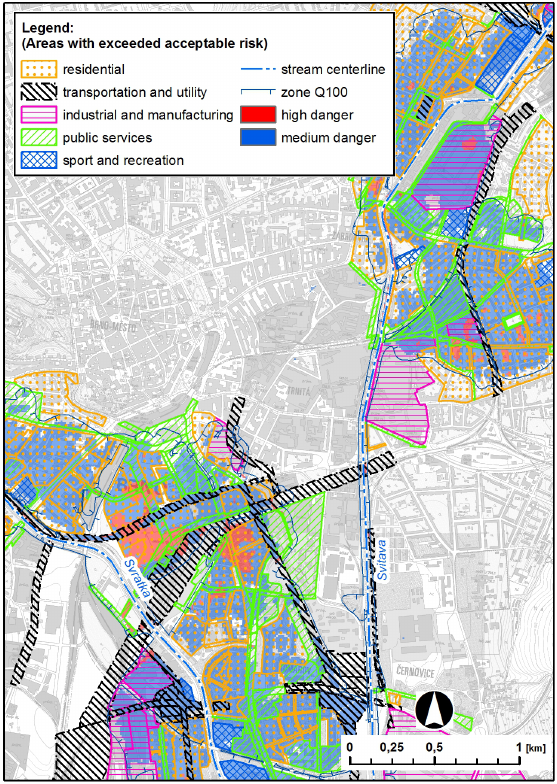
Fig. 6. Example of a flood danger map for the rivers Svratka and Svitava in Brno (original scale 1:10000) (BCM, 2008).